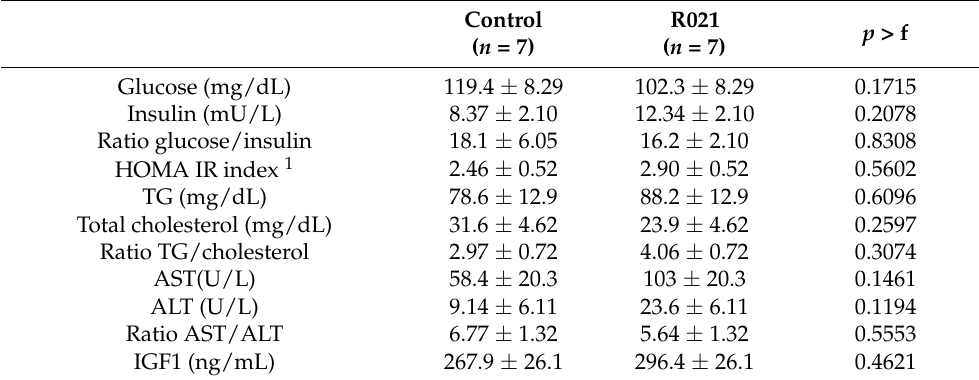
Table 2. Metabolic, hormonal parameters, and hepatic enzymes levels on Day 28 of gestation of ad libitum (Control group) and fed restricted females (105 g/day) during the first two-thirds of gestation and re-fed ad libitum until term (R021 group). Day 0, day of artificial insemination (AI); length gestation, 31